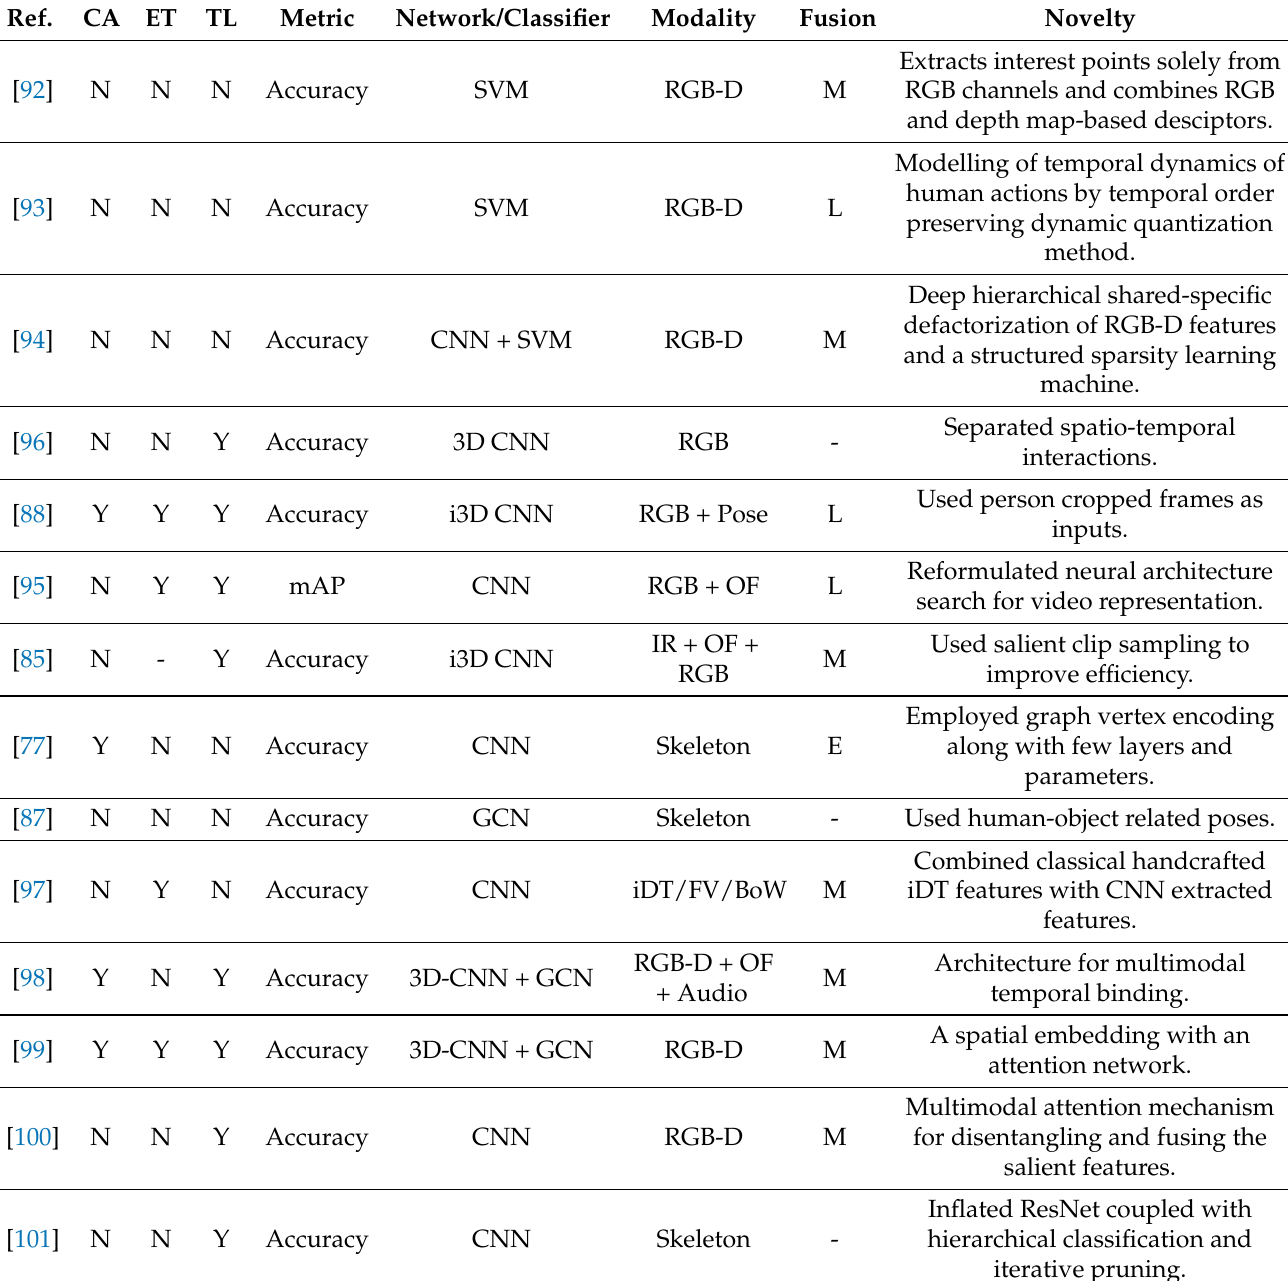
Table 3. State-of-the-art action recognition techniques with their key differences. Notations: CA: Code Availability; ET: Extra Training; TL: Transfer Learning; Y: Yes; N: No; mAP: Mean Average Precision; OF: Optical Flow; IR: Infrared; FV: Fisher Vectors; BoW: Bag of Words; iDT: improved Dense Trajectories; E:Early, M:Middle; L:Late.